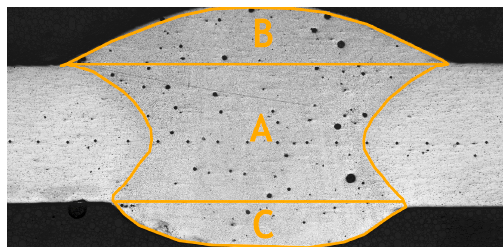
Figure 3. The method to determine the dilutional ratio.